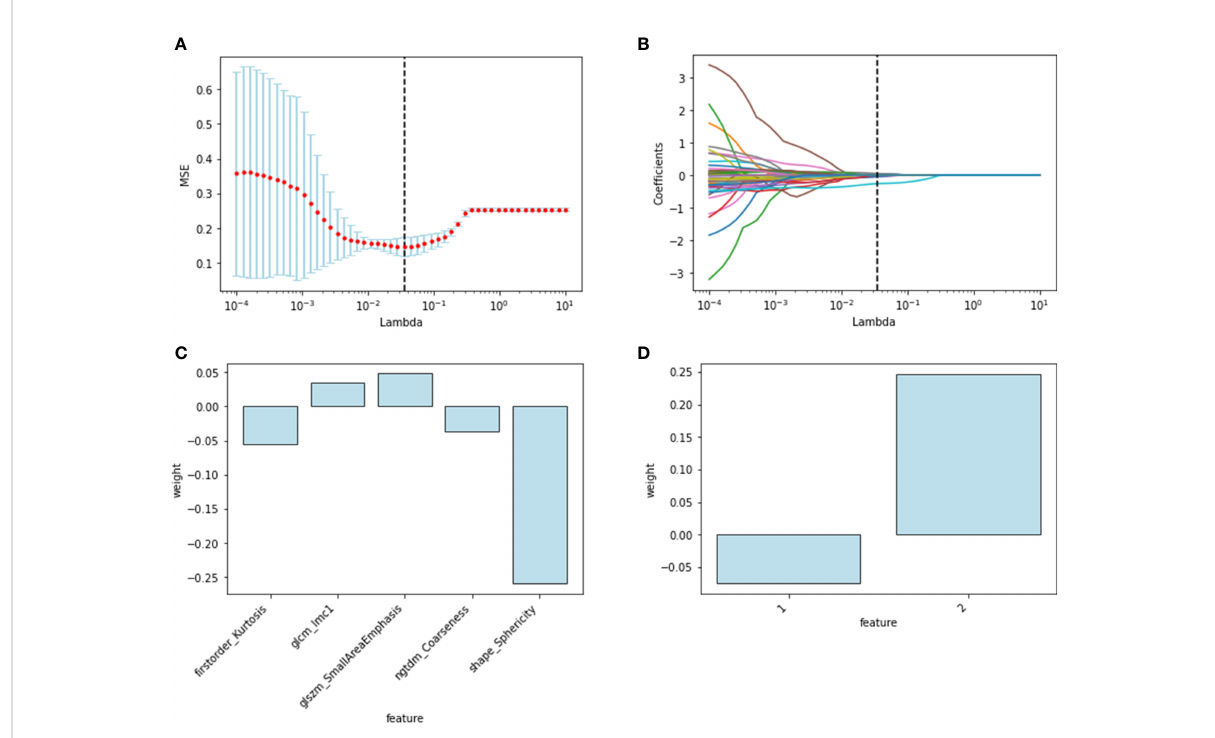
FIGURE 2 Radiomics and deep-learning feature selection. Radiomics feature selection using LASSO logistic regression: (A) selection of the tuning parameter; (B) LASSO coef fi cient pro fi les of the radiomics features. The fi nal selected features with weights: (C) radiomics features; (D) deep learning features.